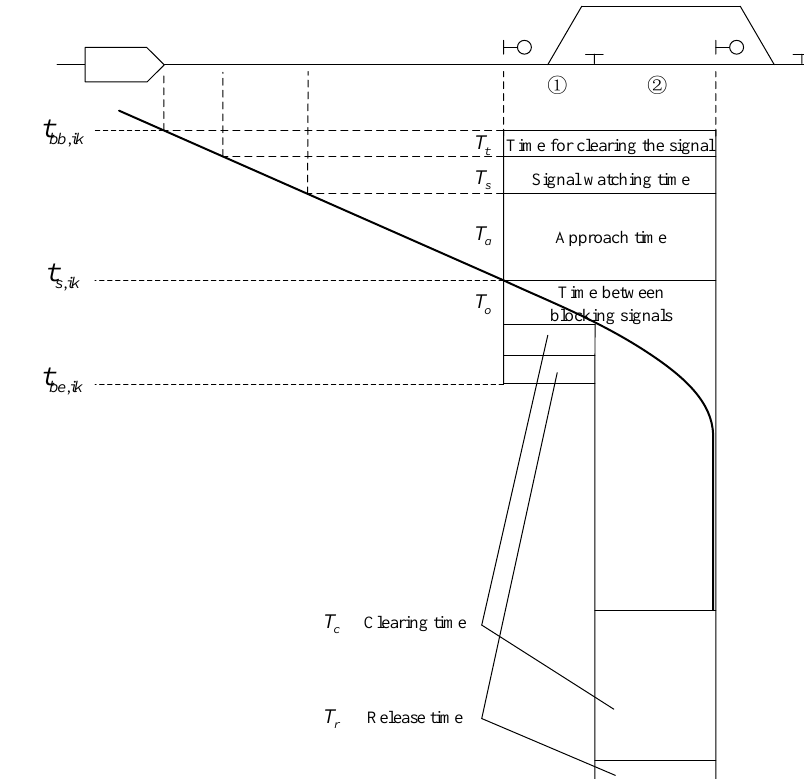
Figure 4. Diagram of the composition of the blocking time when a train has a scheduled stop. Energies 2020 , 13 , x FOR PEER REVIEW 11 of 17